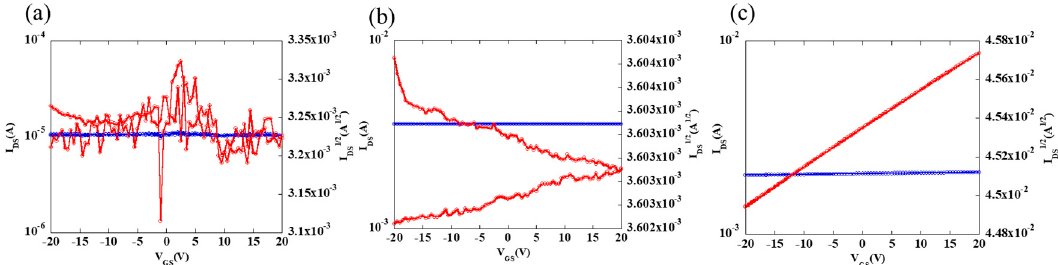
Figure 3. Transfer characteristic curve (I DS ‐ V GS ) of manufactured coplanar top gate Nd ‐ IZO TFTs under different post ‐ annealing temperatures ( a ) without annealing, ( b ) 200 °C ( c ) 300 °C. V GS is varied from − 20 to 20 V with V DS =10.1 V.